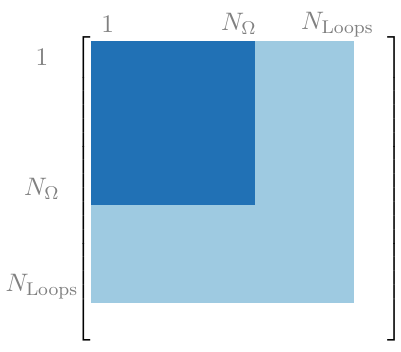
Figure 1. Illustration of Ω truncation for spectrum